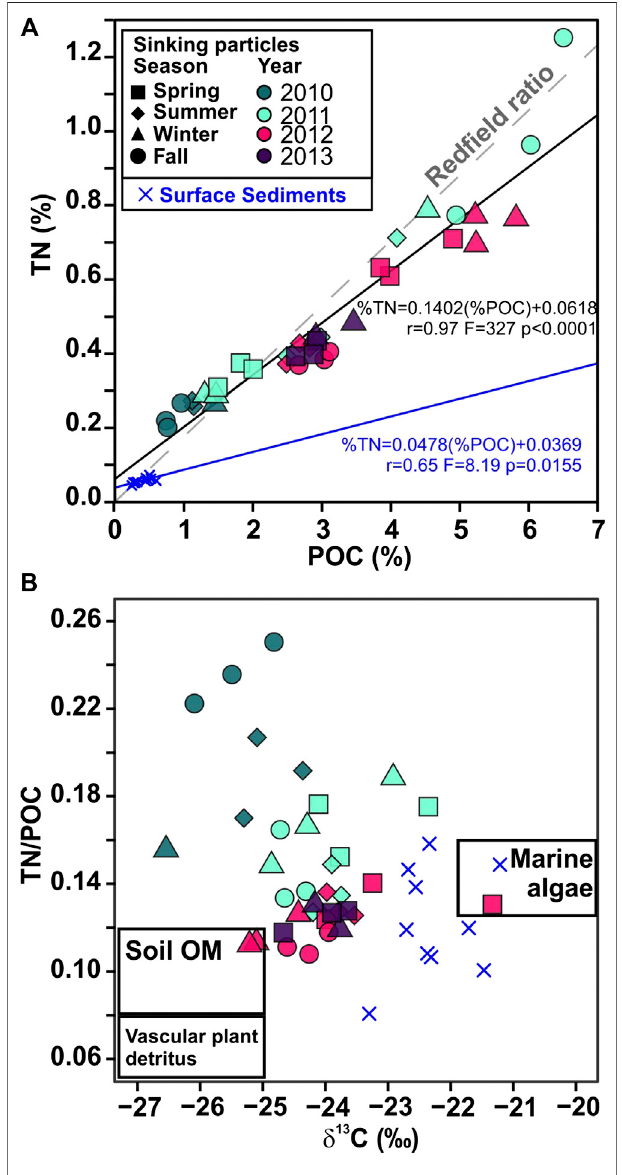
FIGURE 11 | (A) Plot of the weight percent content of nitrogen (TN) vs. particulate organic carbon (POC) in settling particles, and surface sediments samples from Pedrosa-Pàmies et al. (2015). The linear fi t of the data is shown (solid line) along with the Red fi eld ratio N 16 /C 106 associated with the freshmarinephytoplankton(0.17 wt/wt ,dashedline), (B) Plotofmolar TN/OC ratios vs. δ 13 C, in the sediment trap and surface sediment samples. The compositional ranges of end members of organic matter sources (boxes) are derived from previously published studies (Meyers, 1994; Goñi and Hedges, 1995; Hedges et al., 1997; Harmelin-Vivien et al., 2008; Sanchez-Vidal et al., 2013). Symbol shapes correspond to season and colors correspond to sampling